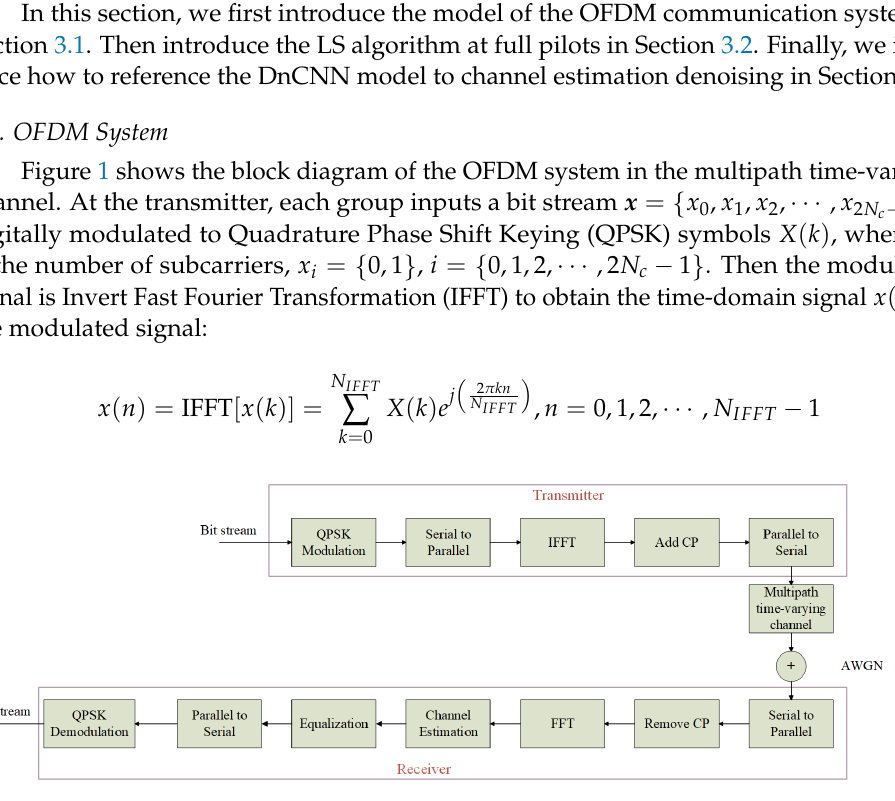
Figure 1. OFDM system architecture for multipath time-varying